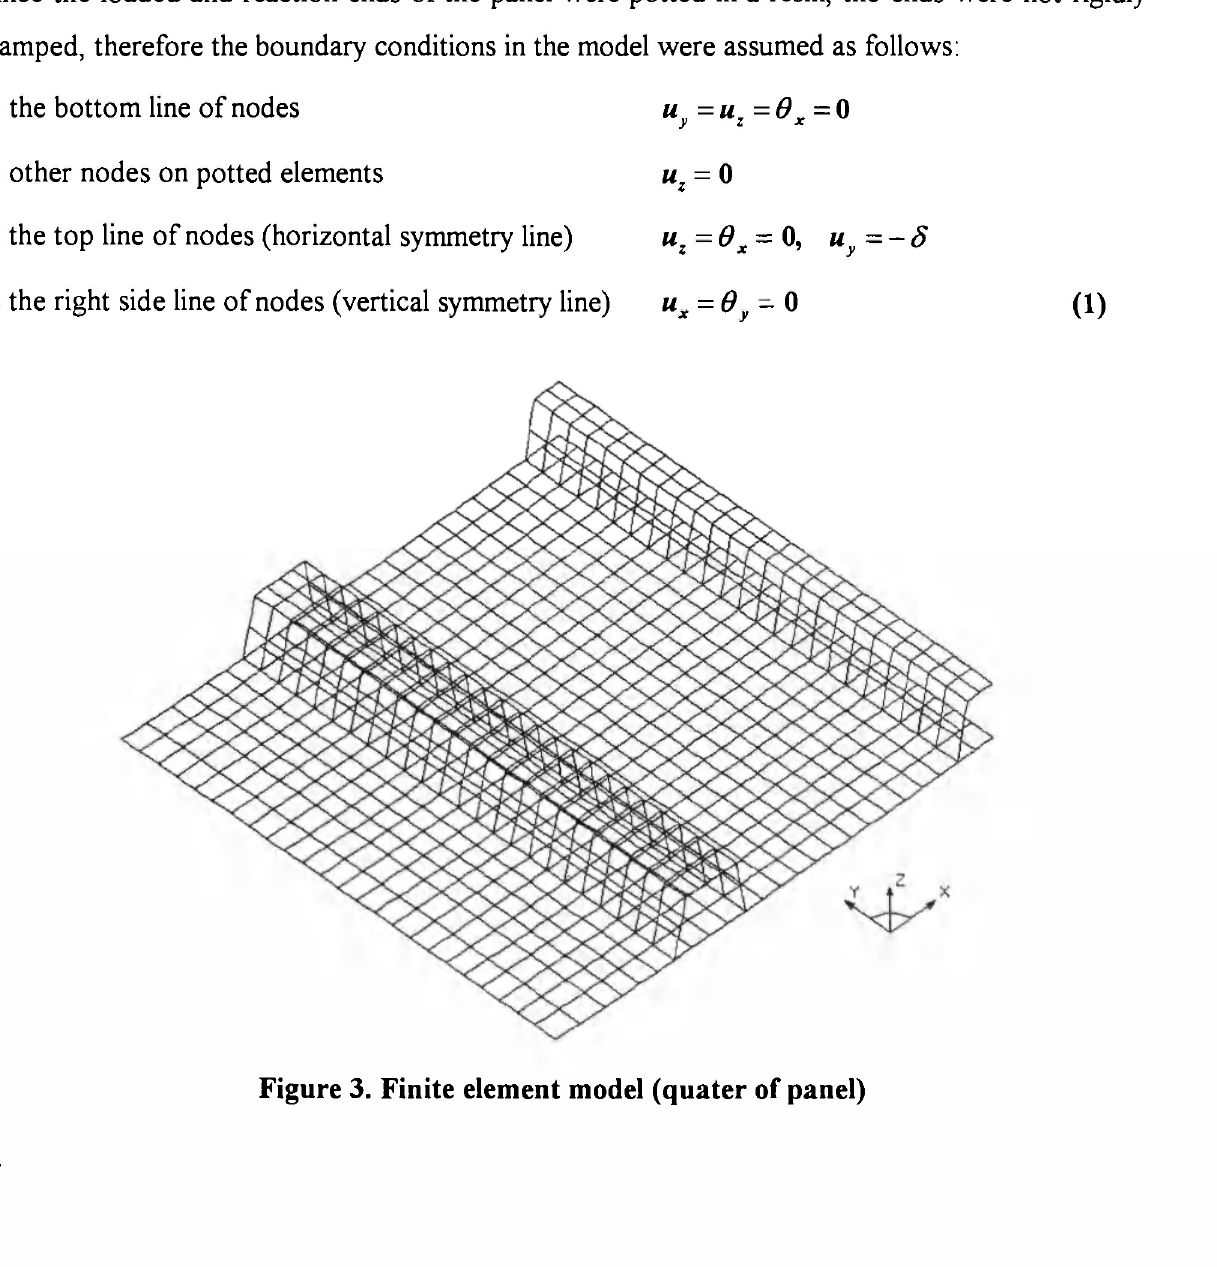
Figure 3. Finite element model (quater of